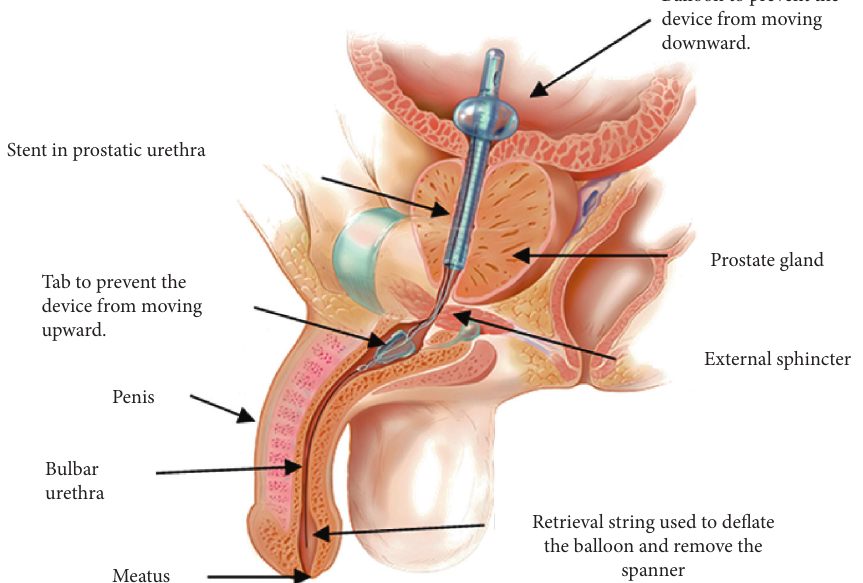
Figure 1: Sagittal view of The Spanner in situ (copyright SRS Medical, used with